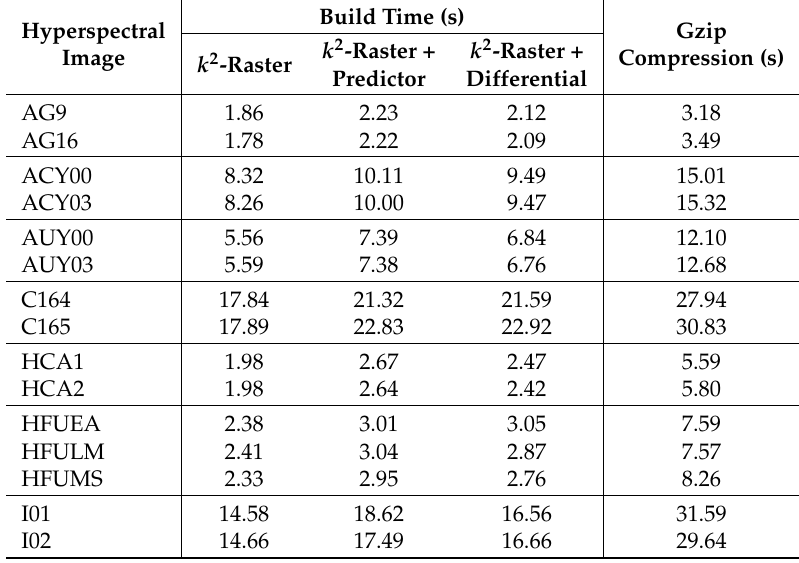
Table 3. A comparison of build time (in seconds) using k 2 -raster only and k 2 -raster with predictive and differential